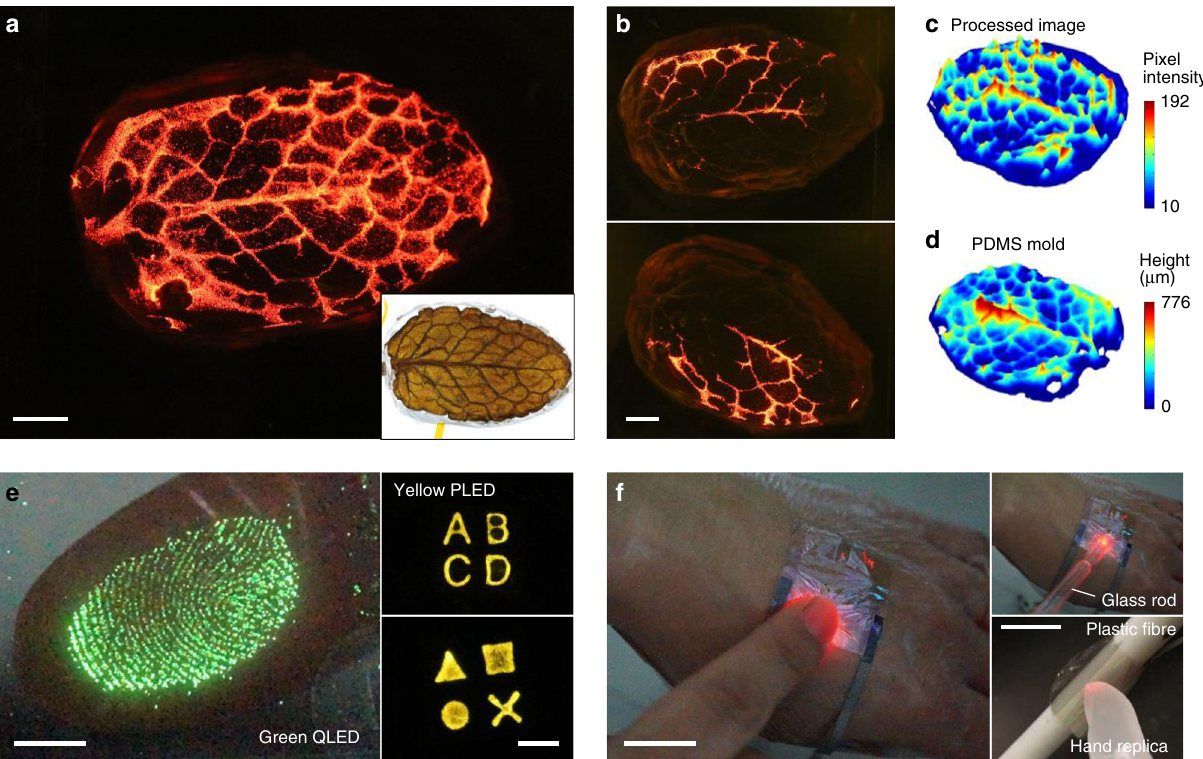
Fig. 5 Super-resolution imaging of pressure distribution. a , b Optical photographs of the photonic skin visualizing the pressure applied with a PDMS replica of a mint leaf when the replica was fully pressed ( a ) and partially pressed ( b ). The inset in a shows the original mint leaf. Scale bars, 2 mm. c 3D plot of pixel intensity of the image in a after Gaussian fi ltering. The Gaussian fi ltering with σ = 20 was carried out to remove the noise and detailed texture information. d 3D surface image of the PDMS replica measured with a surface pro fi ler. e Optical photographs of the photonic skins with various light- emitting devices. The left photograph shows a device with a green quantum-dot light-emitting diode (QLED) touched with a fi nger. The right photographs show a device with a yellow polymer light-emitting diode (PLED) touched with PDMS stamps. Scale bars, 5 mm. f Optical photographs of pressure imaging with freestanding devices laminated on various 3D surfaces. When a fi nger and a glass rod touched the photonic skin laminated on a human hand and a plastic fi bre, it well visualized pressure distribution in real-time. Scale bars, 2